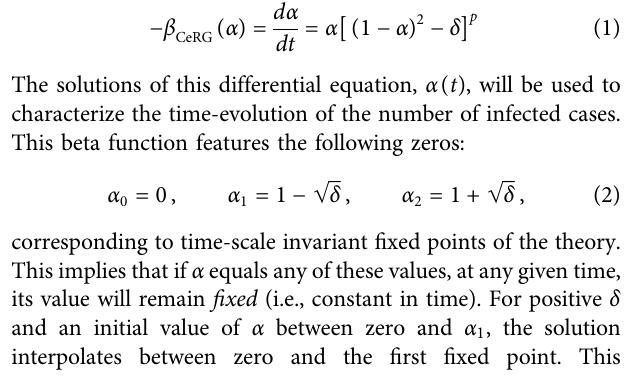
FIGURE1| Emergence ofthe strolling dynamicsfromtheCeRGbetafunction. Leftpanel :illustrationofthebetafunction( − i.e., considering a complex α . The red line represents the trajectory on the real plane, emerging from the real fi xed point at α (cid:2) 0 (red dot): the strolling emerges as the solutionslowsdownwhenpassingbetweenthetwocomplex fi xedpoints(greendots). Rightpanel : (A) betafunctionsand (B) solutionsfor p (cid:2) 0.65andvariouschoices for δ